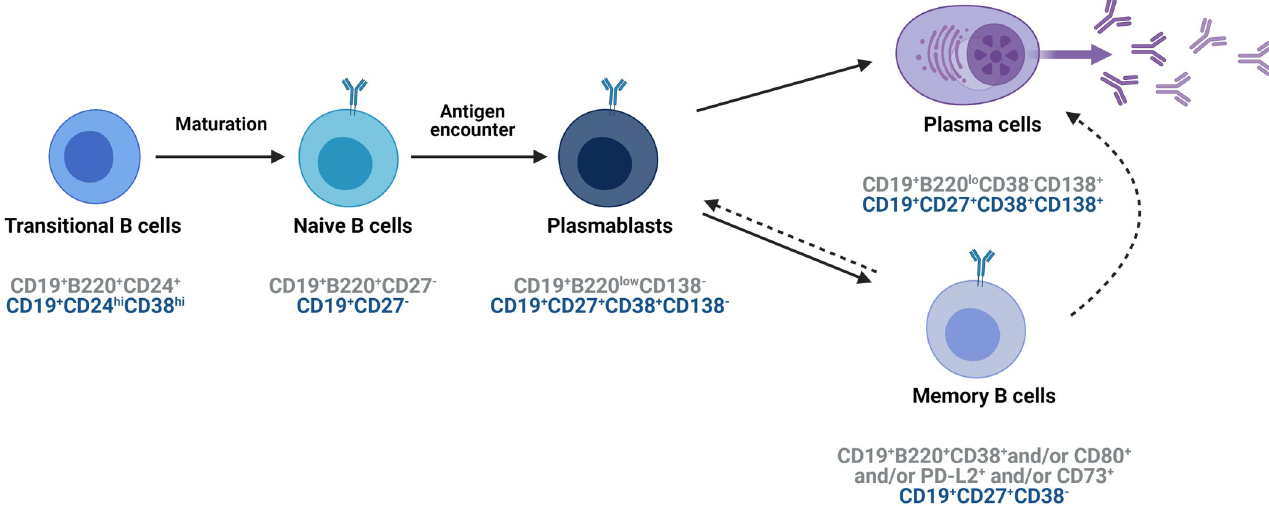
Fig 1. Summary of B cell subsets in mice and humans. Stages of B cell maturation and the expression of cell-specific markers for these B cell subsets in mice (grey) and humans (blue). Created with BioRender.com.